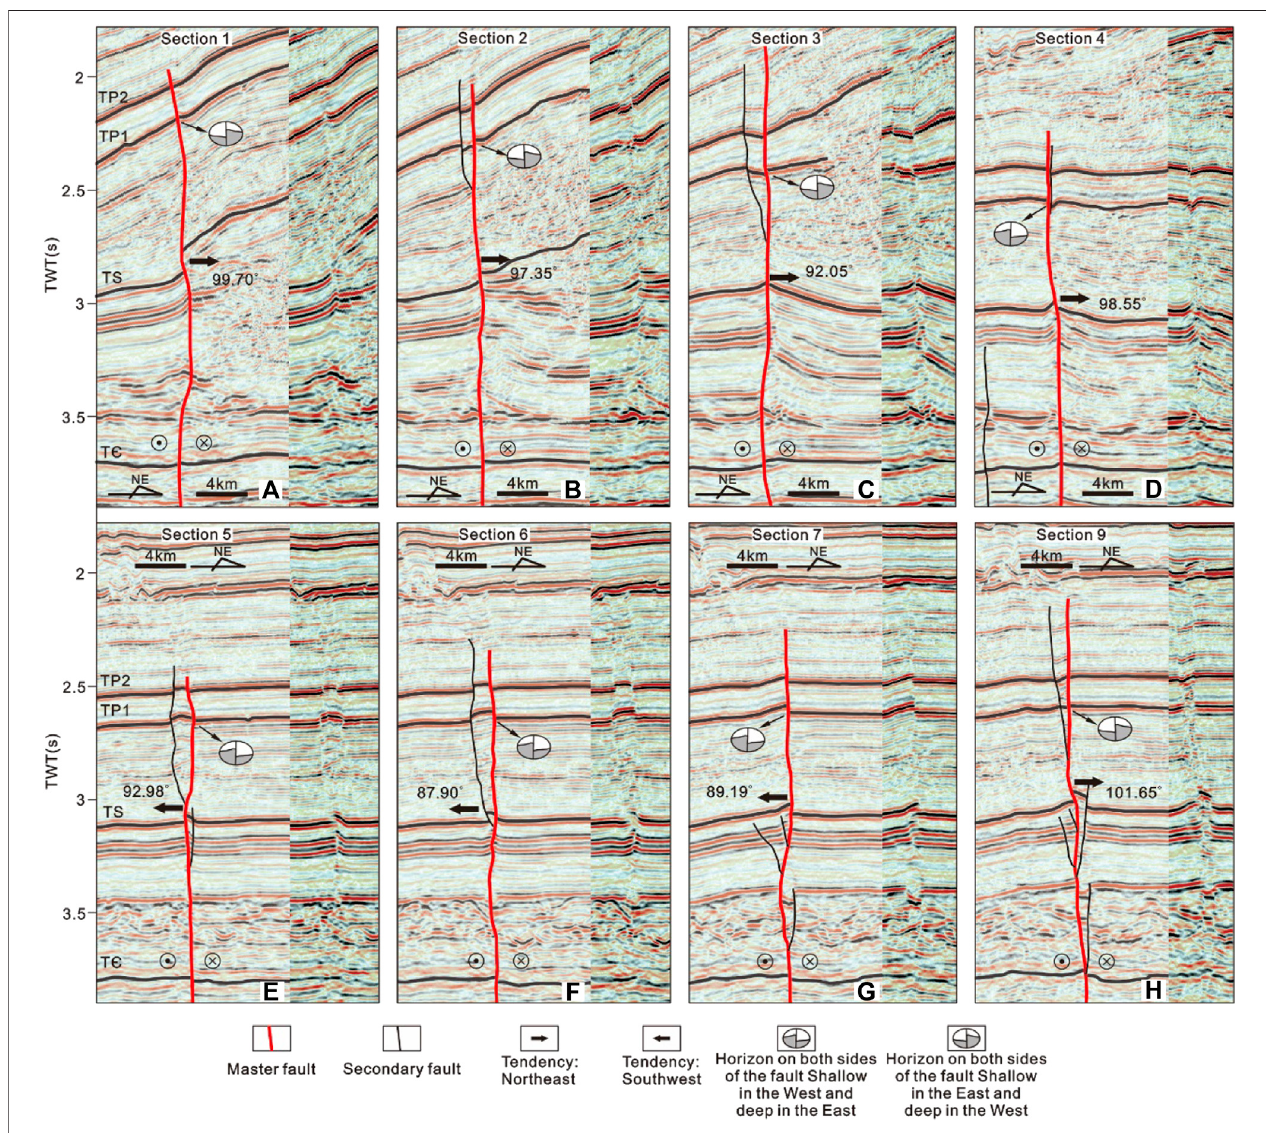
FIGURE 8 | Fault interpretations of cross Section 1 (A) , Section 2 (B) , Section 3 (C) , Section 4 (D) , Section 5 (E) , Section 6 (F) , Section 7 (G) , Section 9 (H) . The uninterpretedrightimagesareshownforcomparisonandcroppedasthecentralpartoftheleftimageswherefaultzonesoccur.See Figure1D forlocation.TWT=two- way